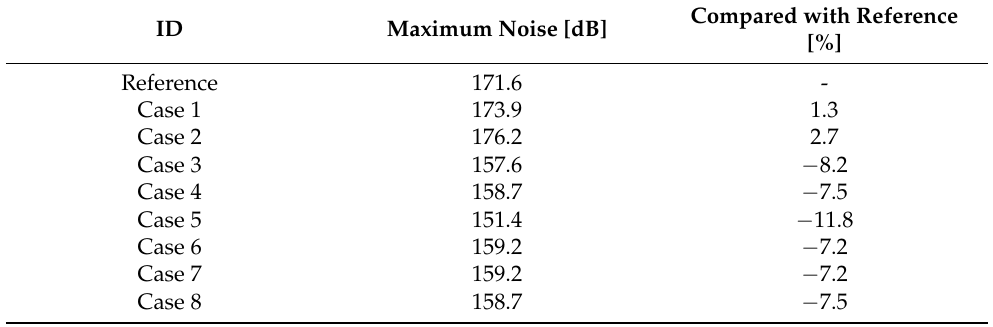
Table 5. Noise level by case.